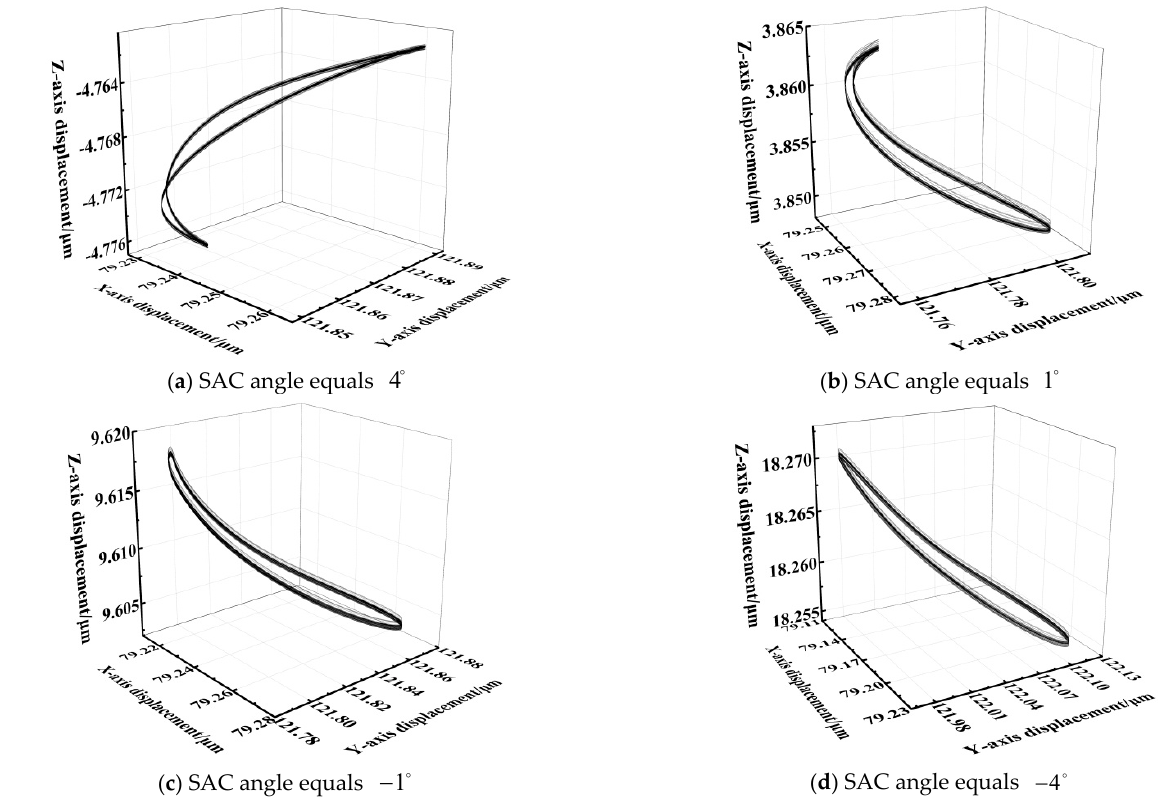
Figure 15. The motion orbit of the inner ring with different self-aligning contact angles (SAC angles). The reason lies in the fact that the axial load will lead to the unbalanced loading of two-row rollers. For instance, if the direction of an axial load is applied to SRBs from left to right, the rollers in the right row will be compressed while the left rollers will be released. At the moment, the phenomenon of unbalanced loading is improved with the SAC angle rotating anticlockwise. Specifically, more rollers in the left row will enter the loading region to share the external load with the rollers in the right row. The load distribution among all the rollers becomes more reasonable, and the motion orbit of the inner ring and seems stretched and smooth.